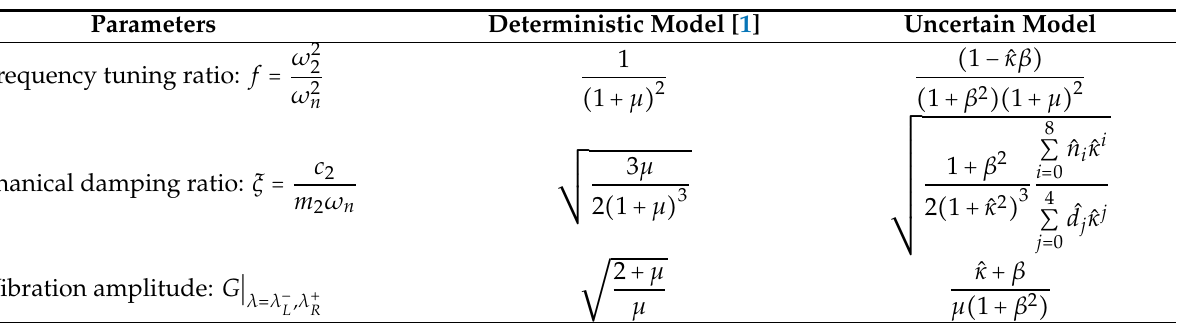
Figure 6. Frequency responses of an uncertain primary system controlled by a TMDI with the proposed design. Solid line: µ = 0.05, ν = 0.01, β = 20%; circle markers: µ = 0.03, ν = 0.03, β = 20%. Moreover, the frequency response curves C1 and C2 correspond to δ = − β and δ = + β , respectively. Table 2. Optimal parameters of TMDs for controlling the vibration of a harmonically forced host structure in both deterministic and uncertain scenarios. Constants ˆ n i , i = 0,1,. . .,8 and ˆ d = 0,1,. . .,4 correspond to n j , j i in Equation (45) and d j in Equation (46) replacing γ with µ , re- √ ( 1 + β 2 )( 1 + µ ) 2 − spectively. ˆ κ =